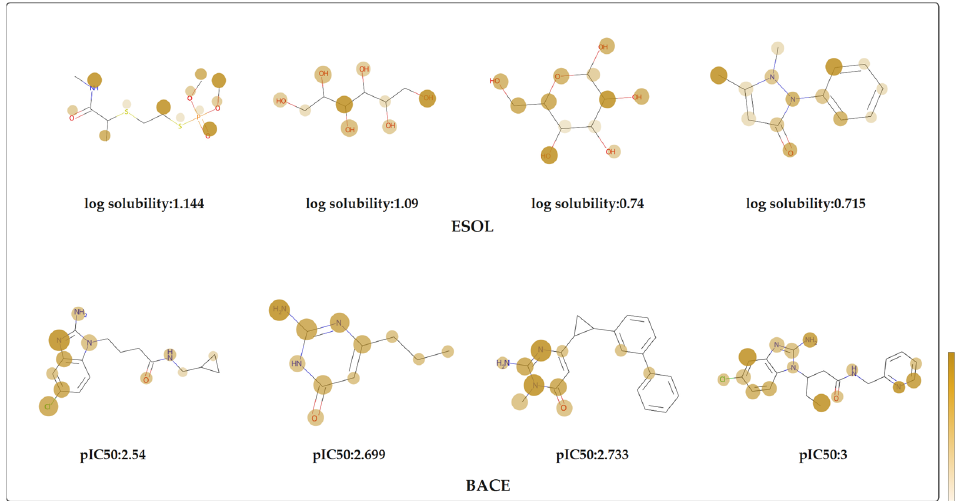
Figure 9. The visualization of molecular attention weights in the ESOL and BACE datasets. The darker the color of the atom, the greater the influence of the atom on the corresponding property.